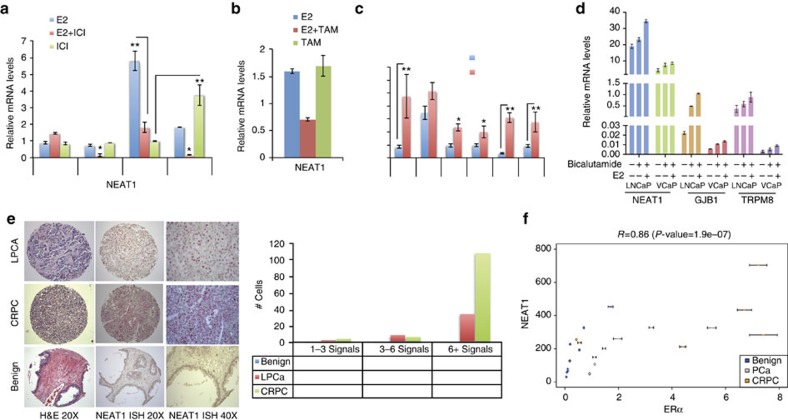
NEAT1 in therapy resistance.(a) NEAT1 expression in VCaP cells treated with E2 (10 nM) at different time points alone, E2+ICI (10 nM+10 μM) or ICI (10 μM) alone. Results are expressed as the mean±s.d. of three independent experiments. *P<0.05, **P<0.01, Student’s t-test. (b) NEAT1 expression in VCaP cells treated with E2, E2+4OHT (10 nM+10 nM) and 4OHT (10 nM) alone for 48 h. (c) NEAT1 expression in VCaP cells treated with or without E2 (10 nM) or E2+Enzalutamide (10 nM+10 μM) at different time points. Results are expressed as the mean±s.d. of three independent experiments. *P<0.05 and **P<0.01, Student’s t-test. (d) qRT–PCR analysis of NEAT1, GJB1 and TRPM8 in LnCaP and VCaP control cells, with bicalutamide treatment (10 μM) alone or in combination with E2 (10 nM) for 48 h. Results are expressed as the means±s.d. of three independent experiments. Results were reproducible between representative experiments. (e) Representative image for RNA ISH of NEAT1 in benign, localized PCa and in advanced disease (top panel). Quantification for the RNA ISH signals shown in the bottom using RNA Spot Studio. (f) Scatter plot showing the correlation between ERα and NEAT1 expression by qRT-PCR in nine cases of benign prostate, seven PCa and seven CRPC. Pearson’s correlation coefficient R=0.86 (P-value=1.9e−07).